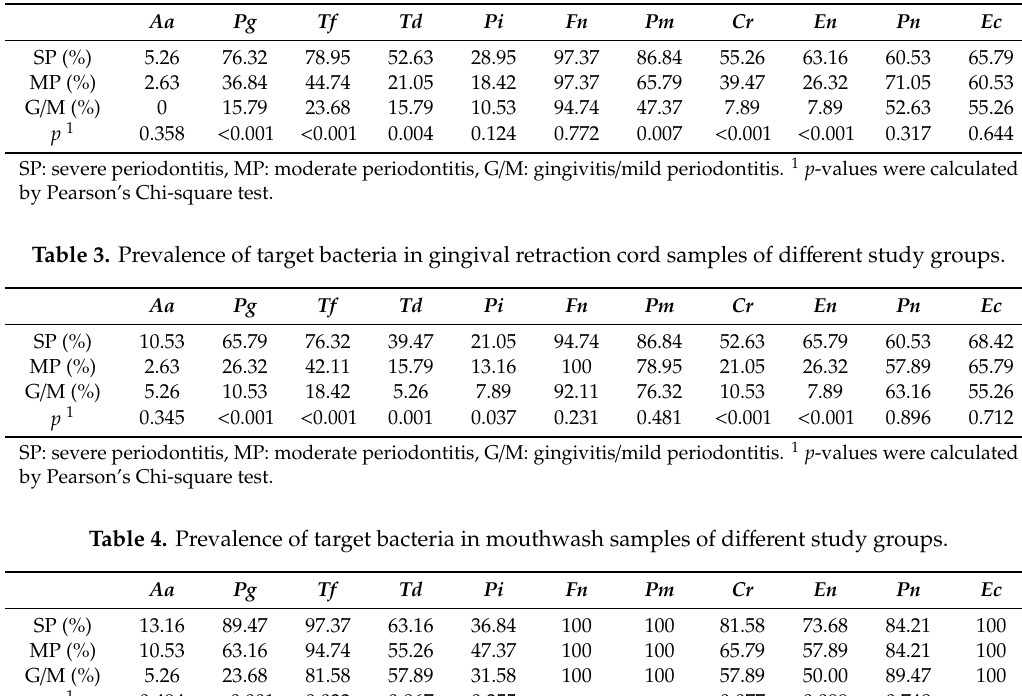
Table 2. Prevalence of target bacteria in paperpoint samples of di ff erent study groups.